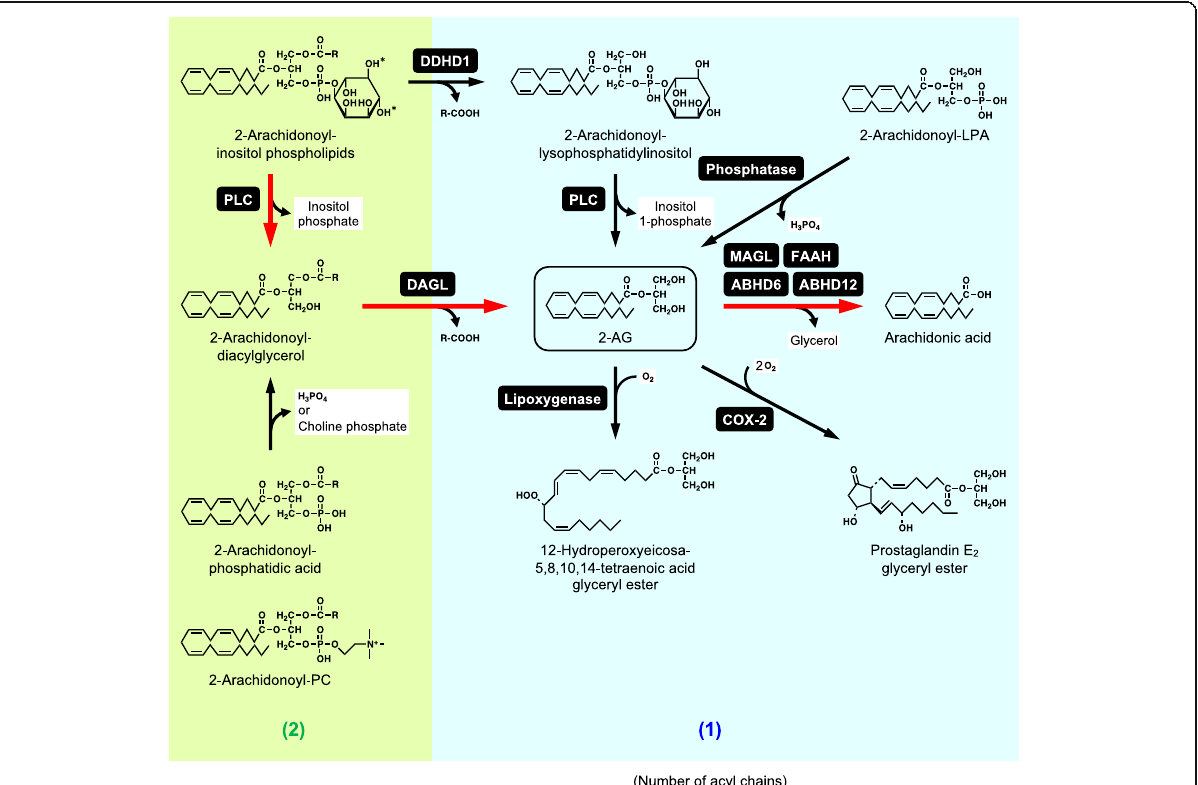
Fig. 2 Metabolism of 2-AG. Red thick arrows represent the major pathway. H 2 O is omitted in the hydrolytic reactions. Two hydroxyl groups indicated by asterisks are phosphorylated in the case of 2-arachidonoyl-phosphatidylinositol 4,5-bisphosphate. Numbers of acyl chains per molecule are indicated in parentheses. COX-2 cyclooxygenase-2, DDHD1 DDHD domain containing 1, PLC phospholipase